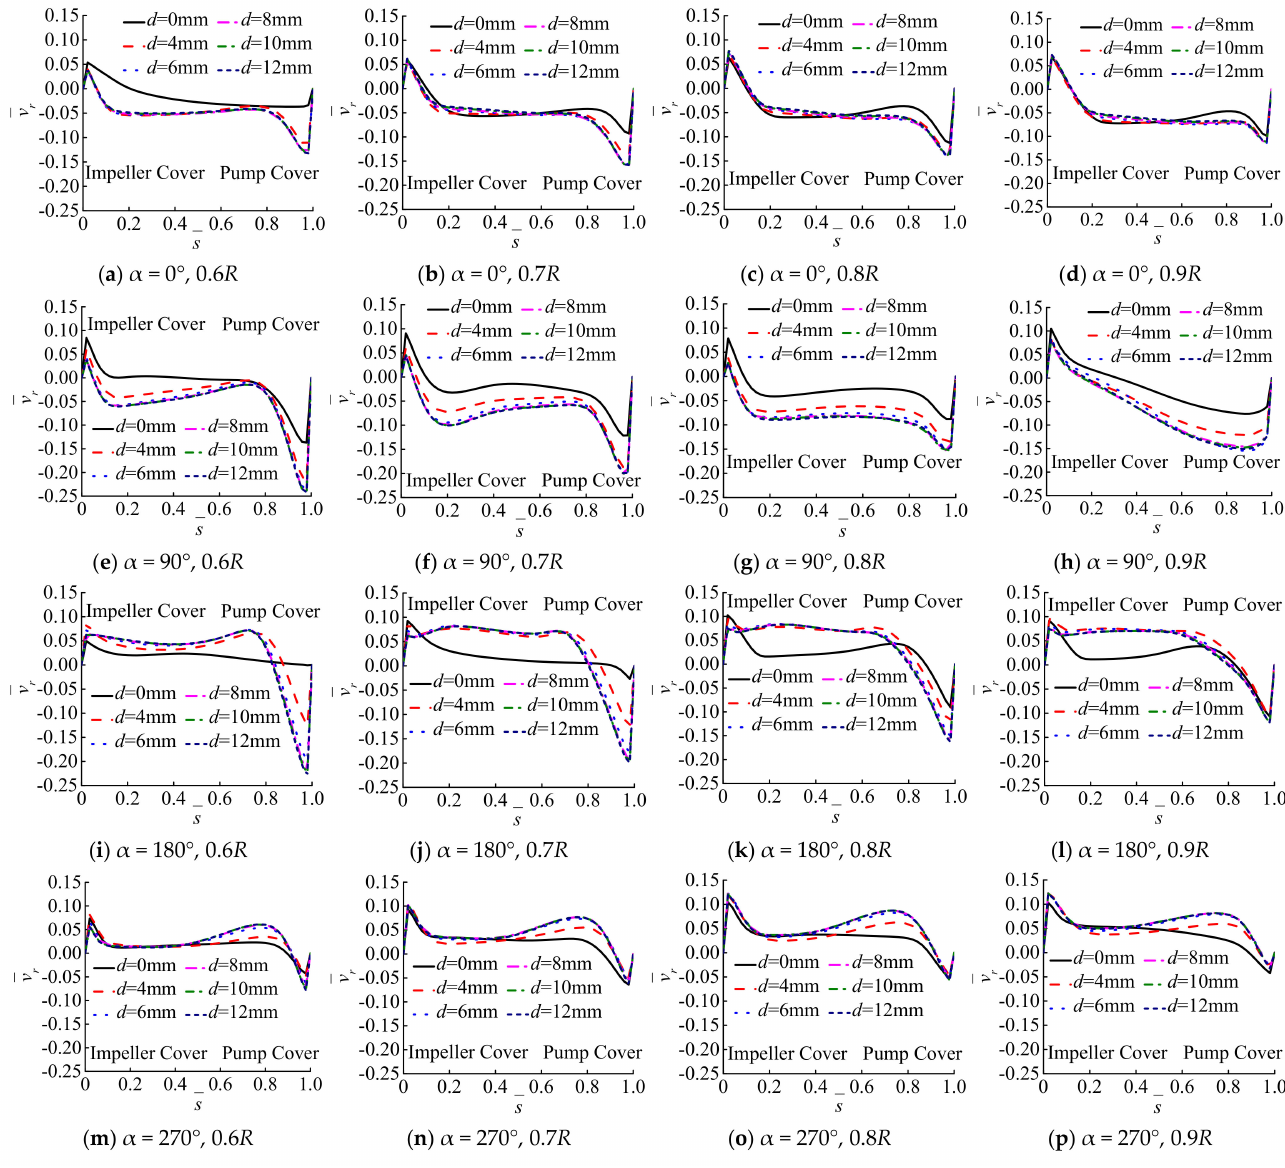
Figure 8. Axial distribution of non-dimensional radial